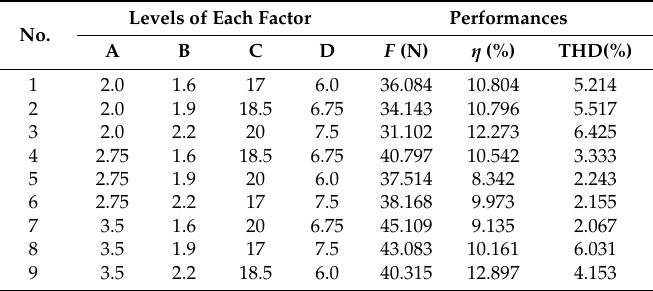
Table 3. Experimental arrays and results of finite element analysis (FEA).